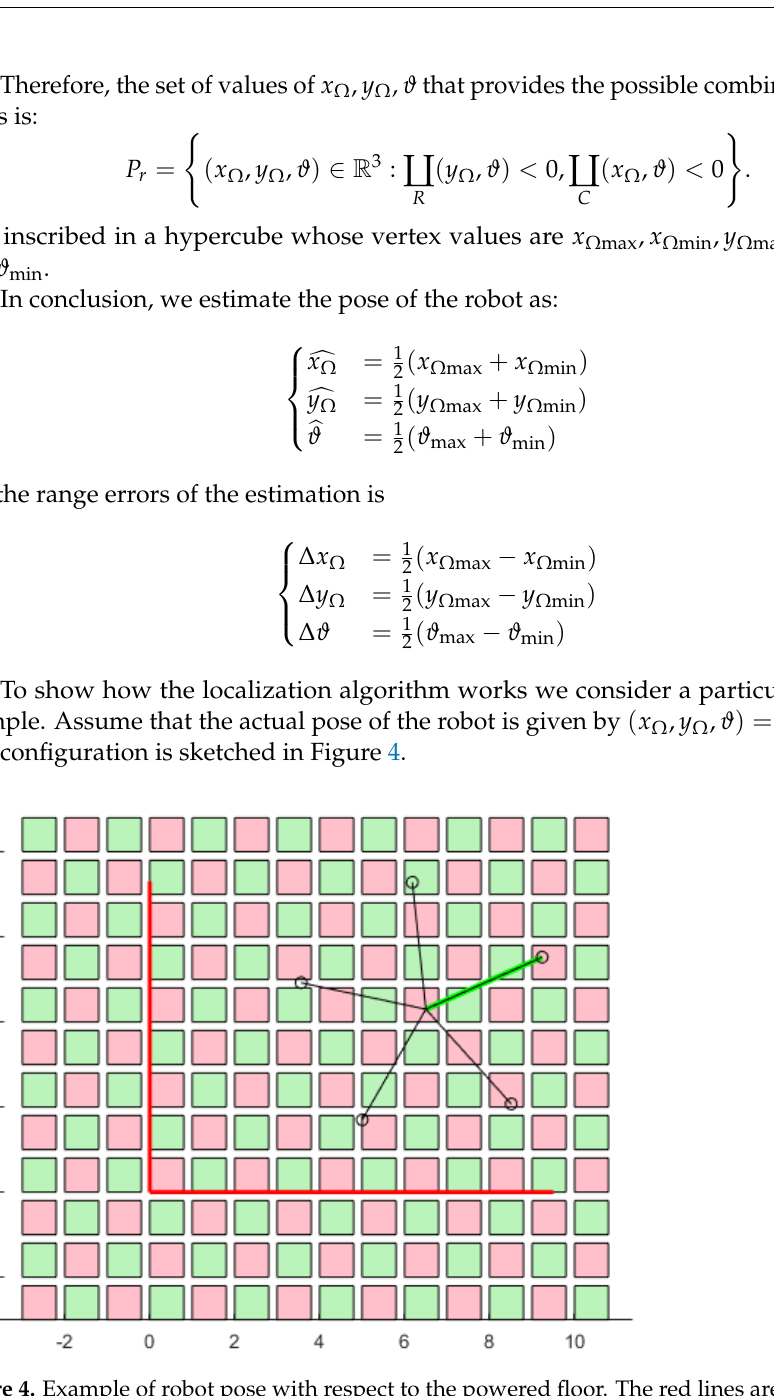
(cid:16) (cid:17) = ( 7.00, 4.13, 0.51 ) and the error bounding boxes are ( ∆ x Ω , ∆ y Ω , ∆ ϑ ) = is (cid:99) x Ω , (cid:99) y Ω , (cid:98) ϑ ( 0.81, 0.29, 0.14 )